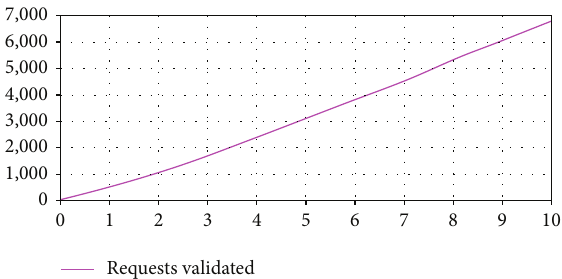
Figure 6: Output variable Requests Rejected